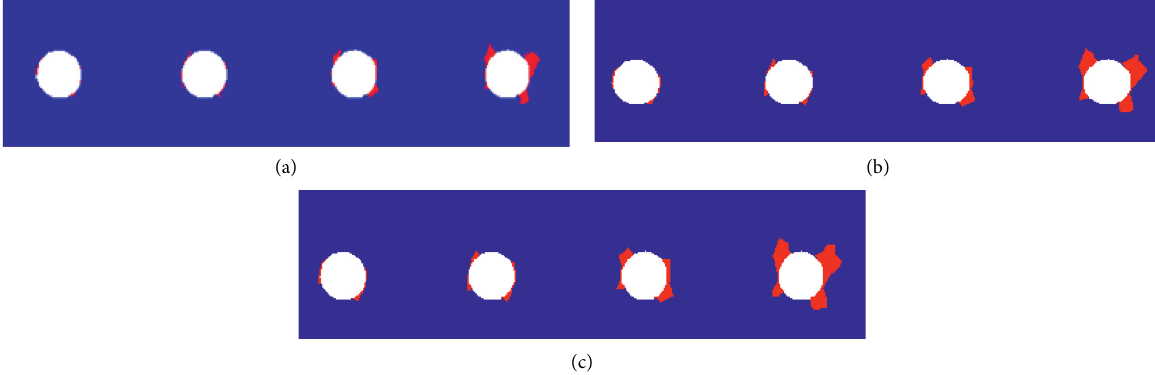
Figure 16: The plastic zone under different hydraulic heads. (a) Hydraulic head (H) s � 50m. (b) Hydraulic head (H) s � 80m. (c) Hydraulic head (H) s �